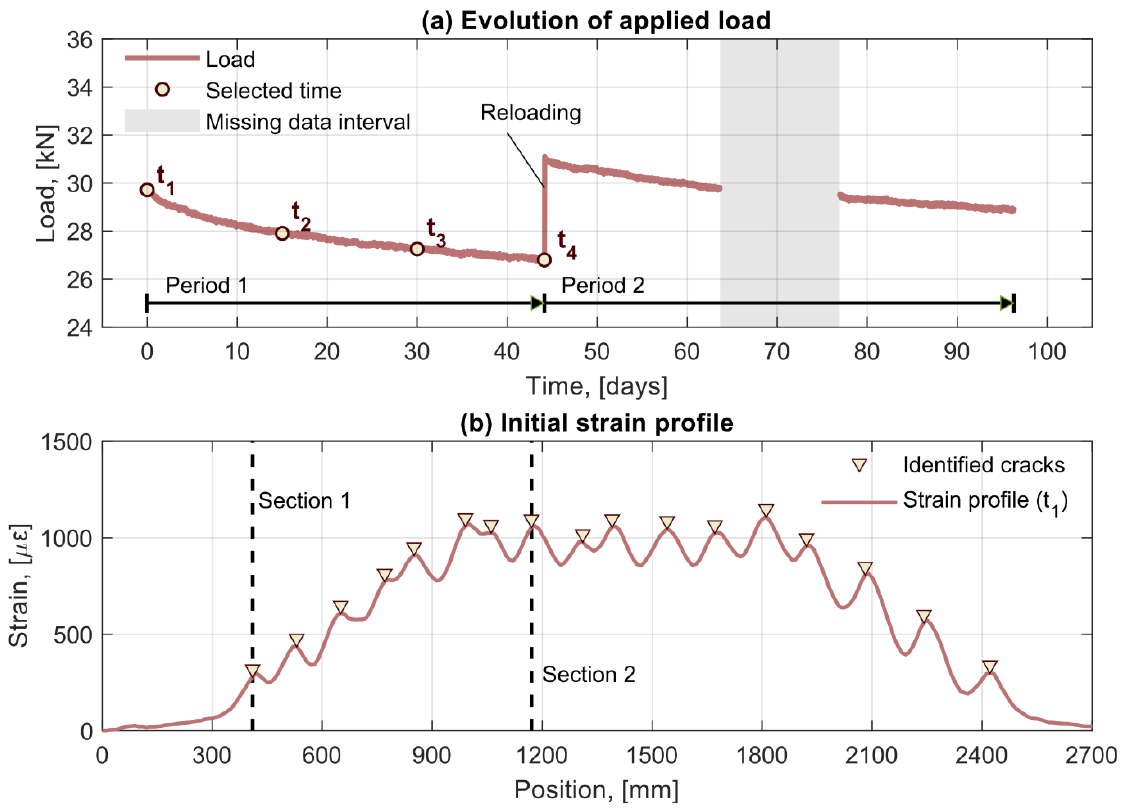
Figure 4. ( a ) Time evolution of the load for the beams subjected to sustained deflection where four selected times of interest (t 1 , t 3 , t 3 , t 4 ) are indicated by markers. ( b ) Strain profile at one of the tensile reinforcement bars of beam 5 at the beginning of the test. Triangular markers indicate the positions of identified cracks and dashed lines highlight the position of two sections of interest, a crack in the shear span (Section 1) and a crack in the constant moment region (Section 2).